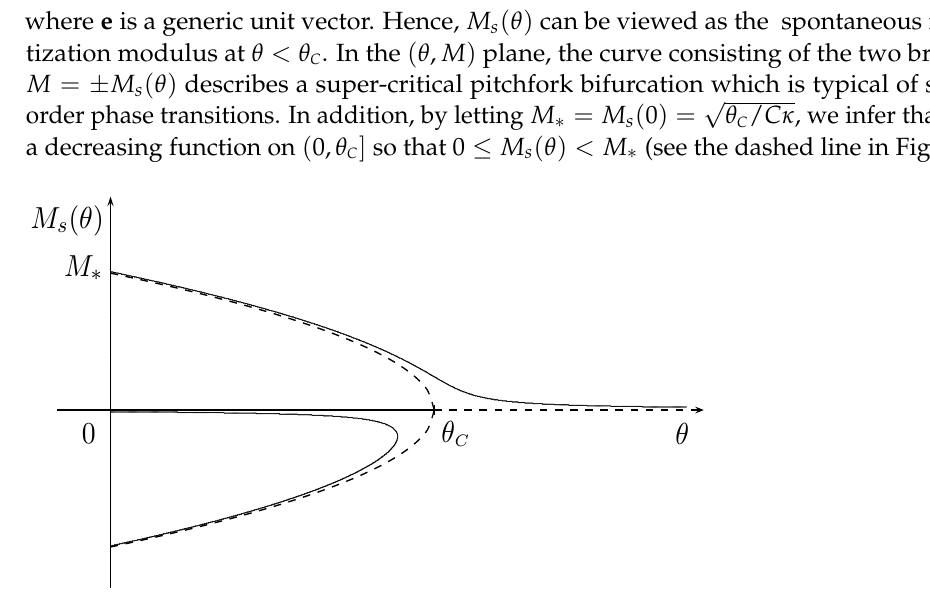
= 0.05, solid curve) and unperturbed ( H = 0, dashed curve) Figure 1. The perturbed (solid) and M unperturbed (dashed) pitchfork bifurcations. Figure 1. Plot of the perturbed ( H super-critical pitchfork bifurcations: C = κ =